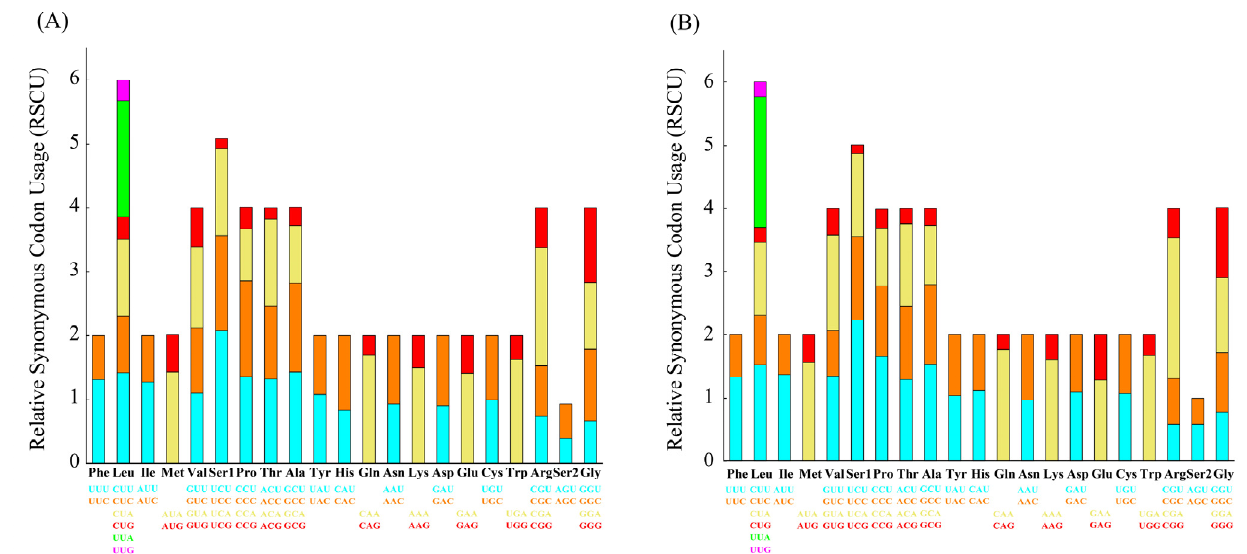
Figure 3. Relative synonymous codon usage (RSCU) of mitogenome of L. boringii ( A ) and L. liui ( B ).